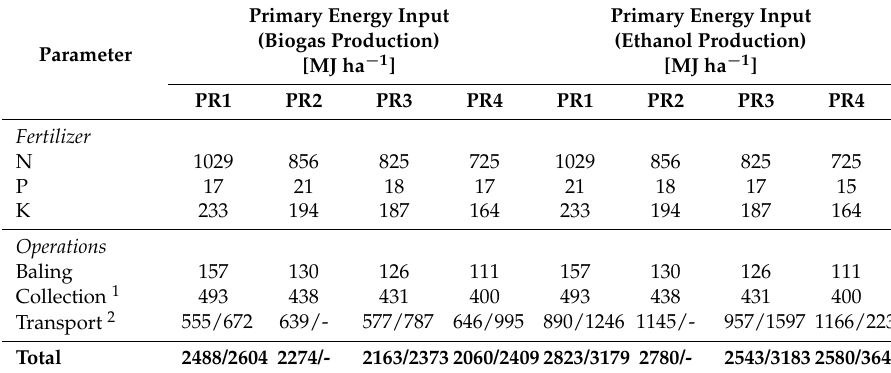
Table A6. Primary energy input in winter wheat straw production in the different production regions (PR) for the production of biogas and ethanol, when removing amounts of straw according to the technical/restricted straw